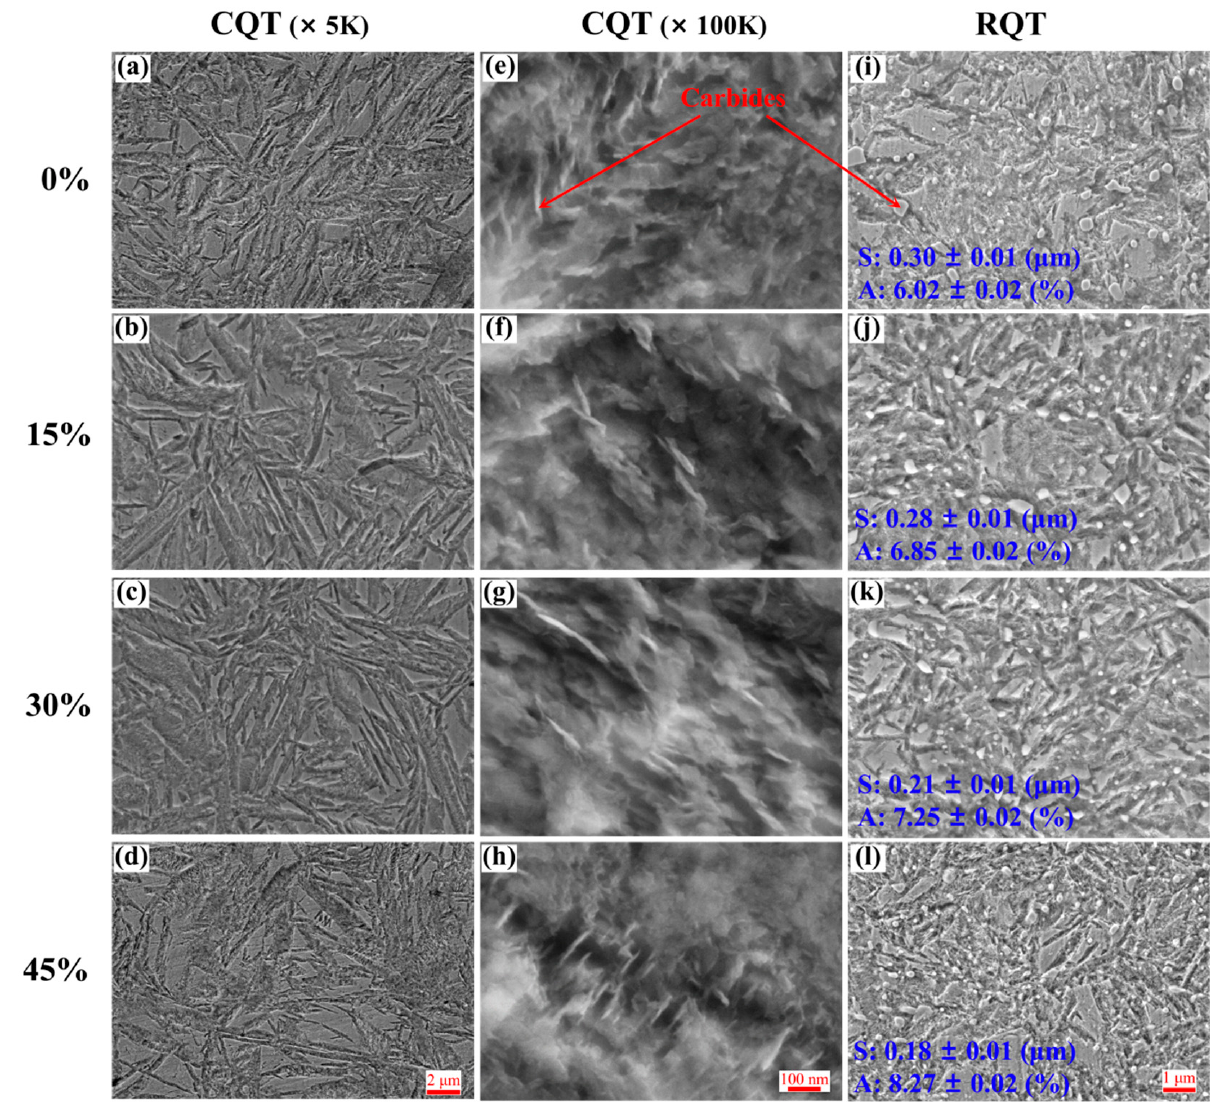
Figure 6. SEM morphology in different hot rolling reduction after the CQT and RQT processes: ( a ‐ d ) CQT specimens at the multiples of 5K; ( e ‐ h ) CQT specimens at the multiples of 100K; ( i ‐ l ) RQT specimens.